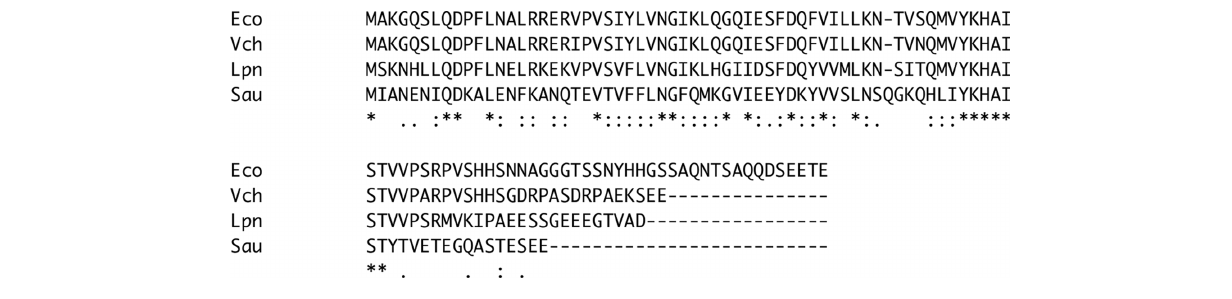
FIGuRe 2 | Alignment of hfq proteins from E. coli (eco), V. cholerae (vch) , L. pneumophila (Lpn), and S. aureus (Sau) was performed with ClustalW2 (Chenna et al.,